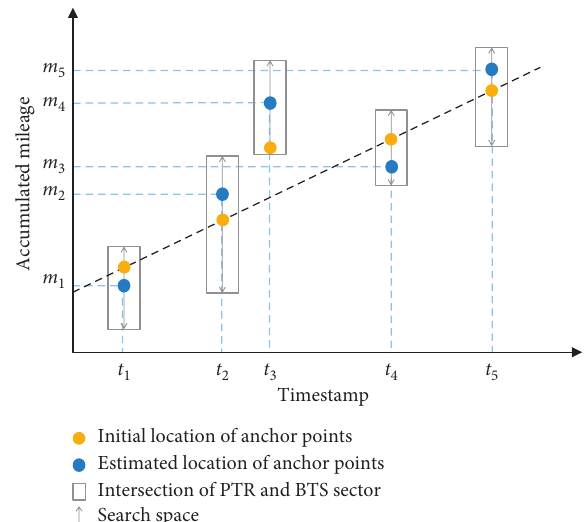
Figure 4: Heuristic optimization of the localization of anchor points.